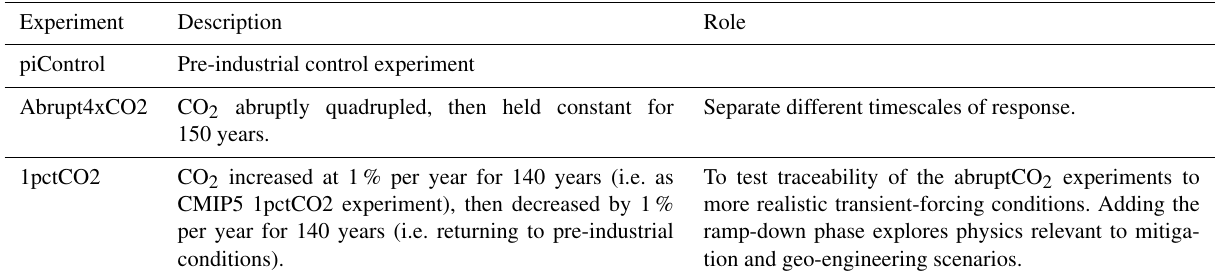
To test traceability of the abruptCO 2 experiments to more realistic transient-forcing conditions. Adding the ramp-down phase explores physics relevant to mitiga- tion and geo-engineering